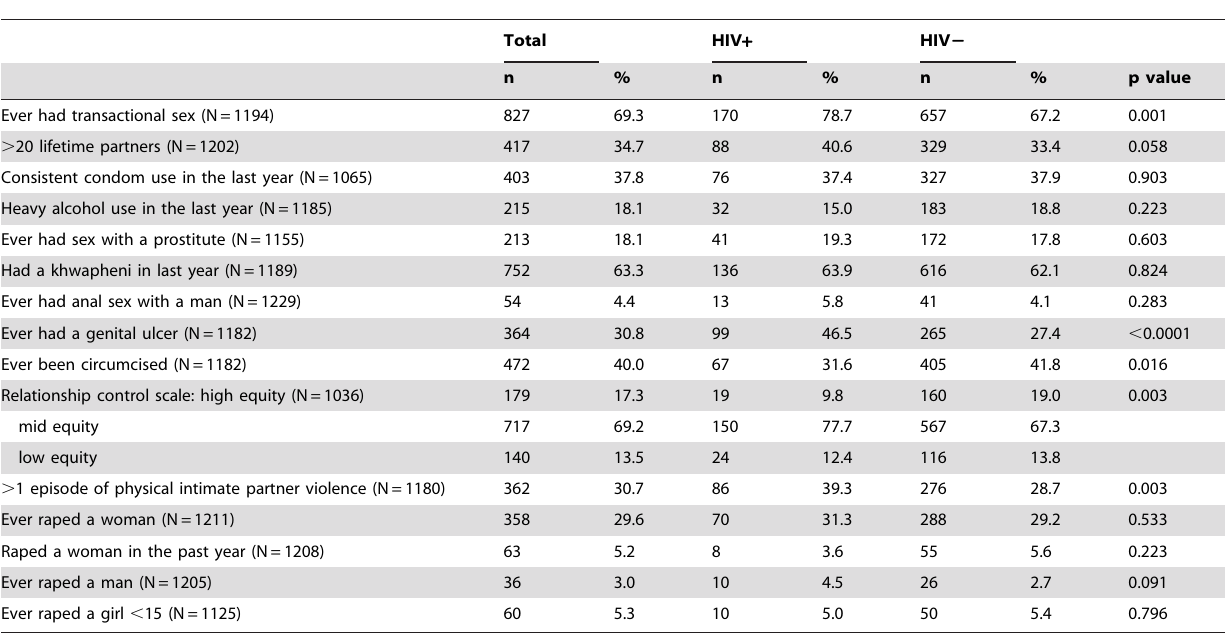
Table 2. Sexual behaviours, violent practices and other potential HIV risk factors by HIV